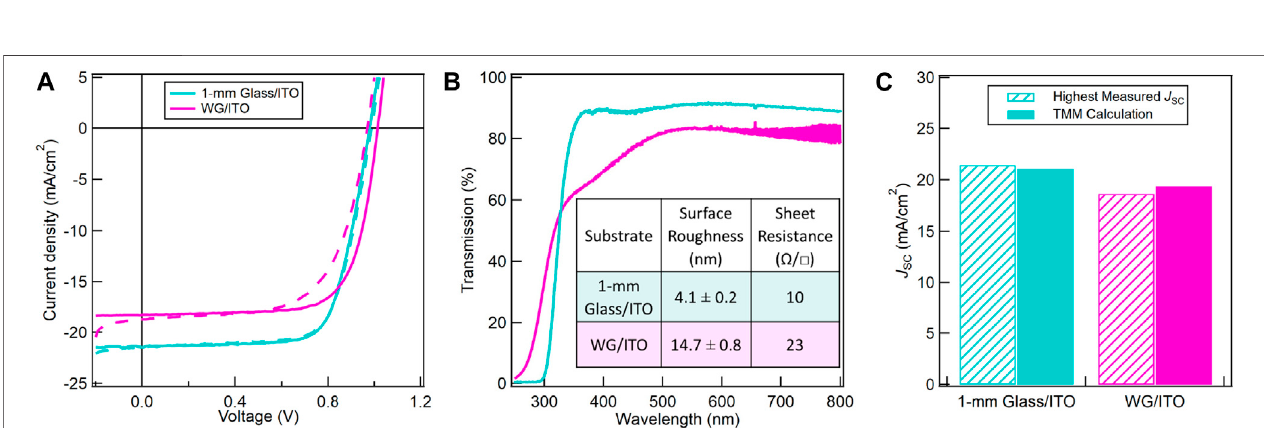
FIGURE6|(A) Championforward(dashed)andreverse-scan(solid)device J-V curvesforPSCsonWG/ITOfabricatedwithTANiO x +TAMAPbI 3 (TA/TA,black)orPCNiO x +TAMAPbI 3 (PC700V/TA,green)withNiO x photoniccuredwithasinglepulseat700 Vlampvoltageand450 µspulselength. (B) Averagereverse-scandevice V OC , J SC ,FF,and PCEforPSCsmadewiththesameconditionslistedin (A).(C) Thermalannealingvs.photoniccuringprocessingtimes(inlogscale)forNiO x fi lmsmadewiththesameconditions used in (A) .